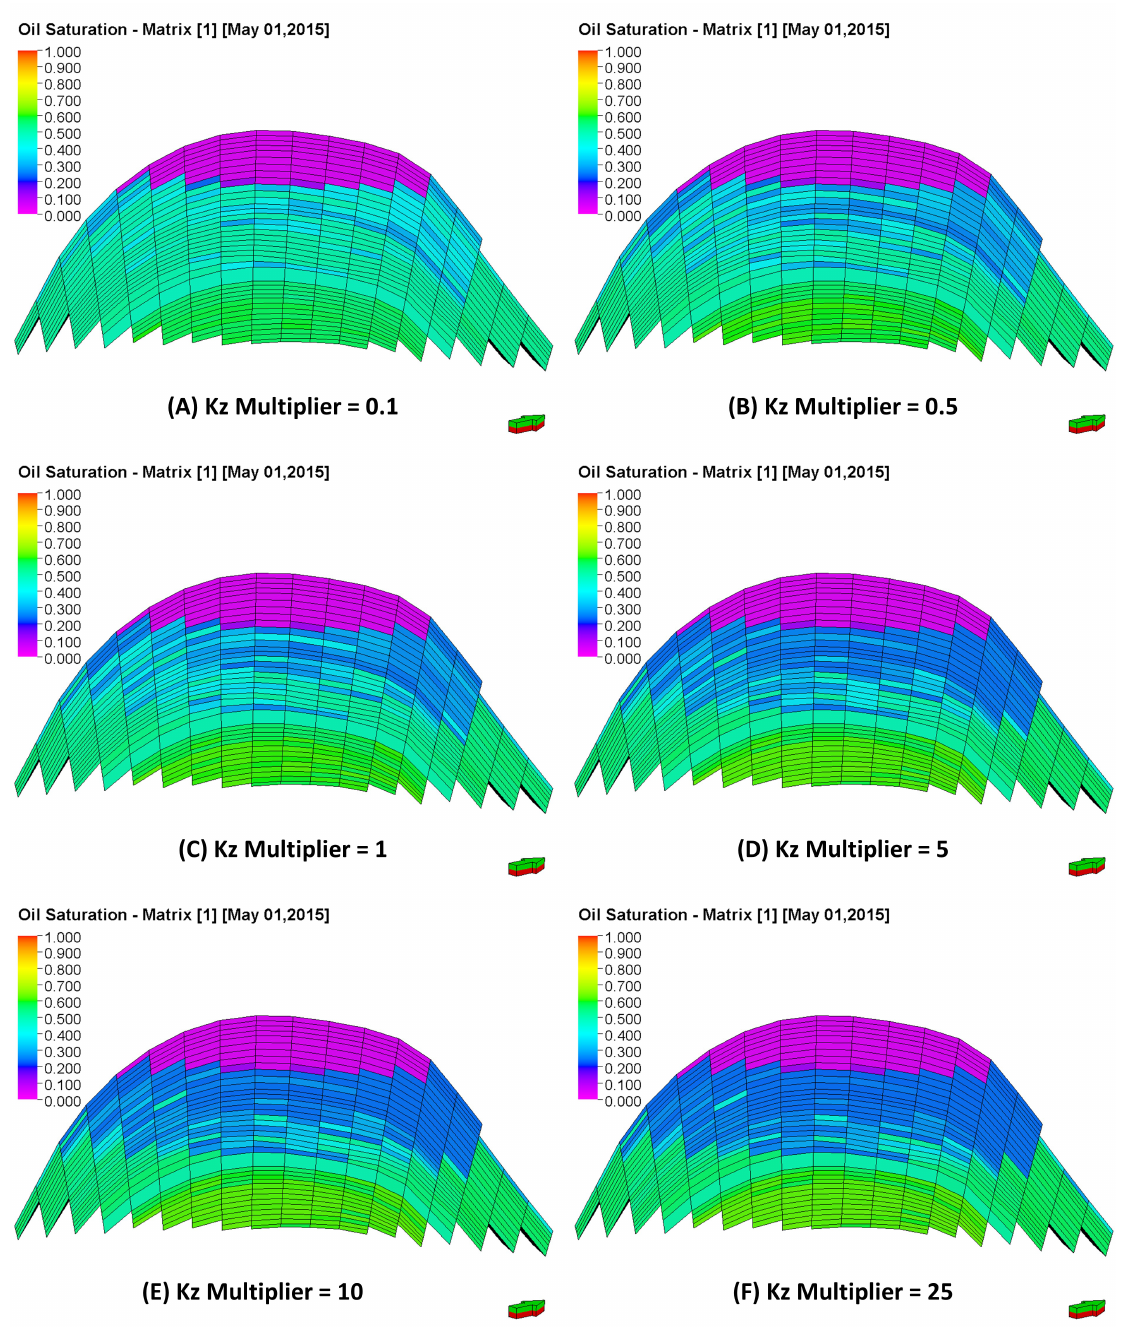
Figure 20. The effect of various vertical permeability of the matrix on the oil saturation, hence the oil recovery from the matrix blocks. The oil saturation is illustrated by the legend where the purple color represents zero saturation percent while the red color represents 100% of oil